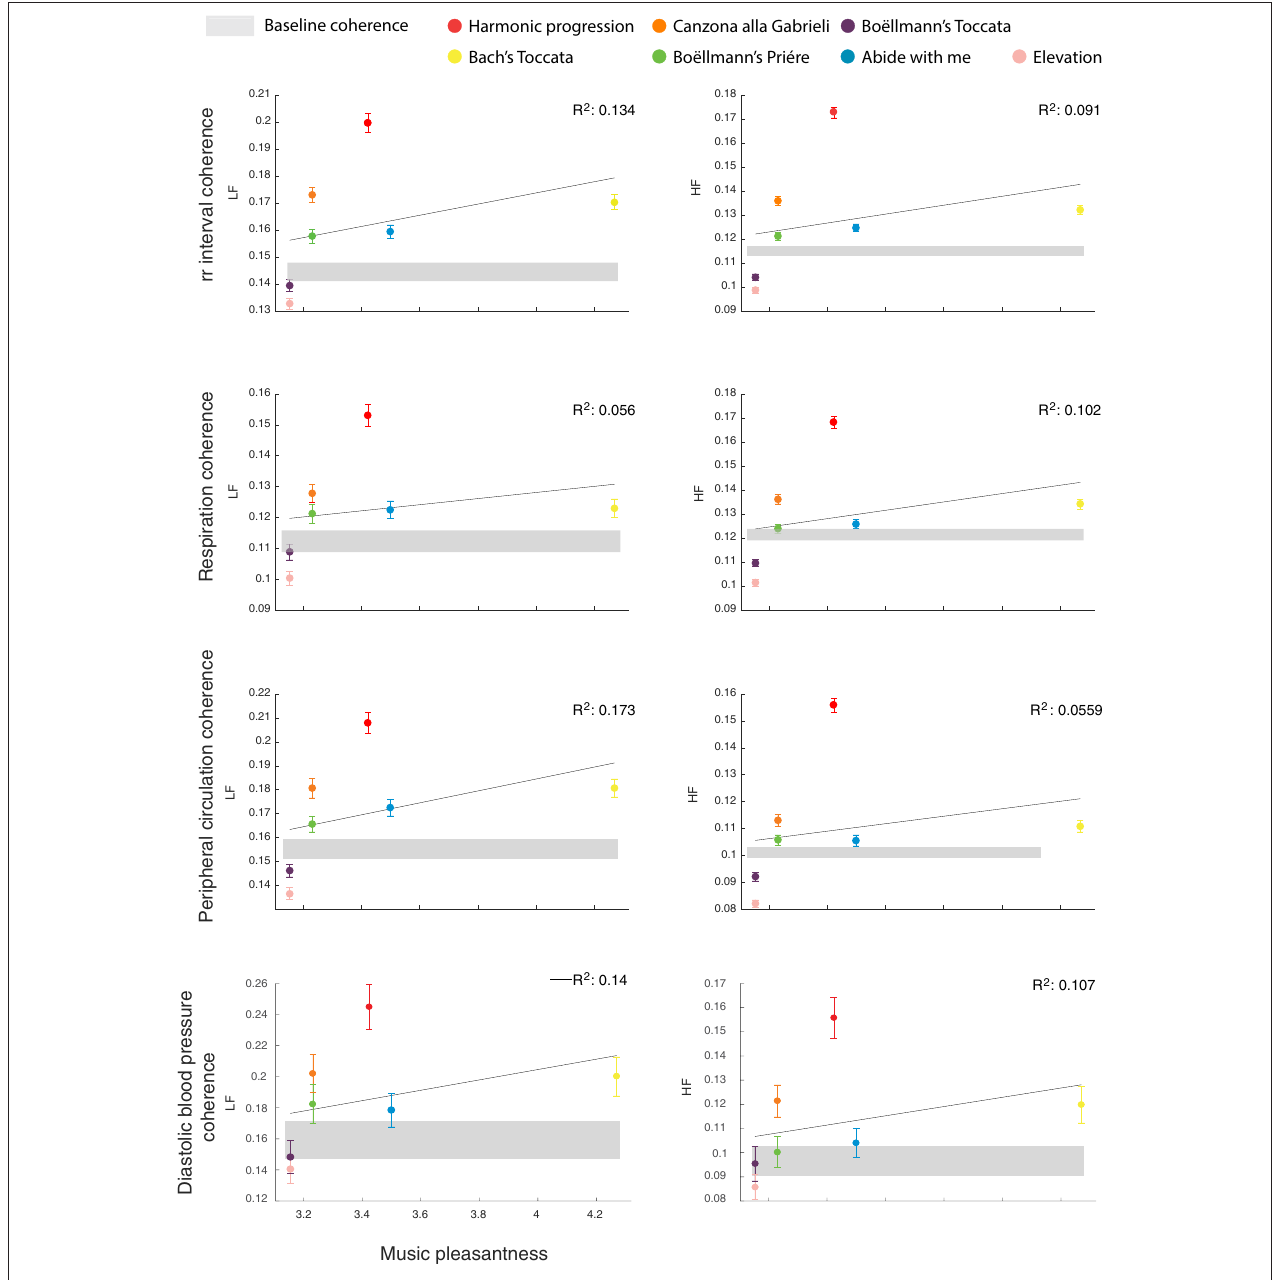
FIGURE 3 | Changes in group synchronization show weak dependence on subjective music appreciation. Conventions are the same as in Figure 2 , but here group synchronization is plotted as a function of subjective ratings of music pleasantness. A trend can be noticed toward greater group synchronization for music that is perceived as more pleasant, but the amount of variance in synchronization explained by this factor is